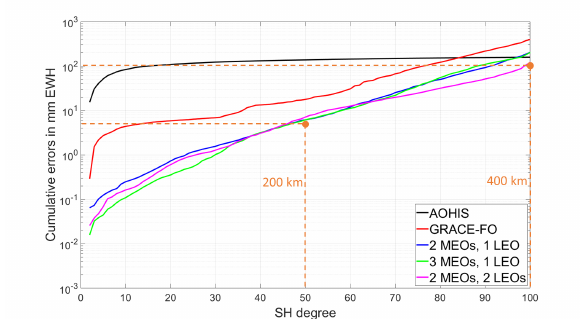
Fig. 7. Cumulative signals/errors when including instrument errors and aliasing errors from hydrology, ice and solid Earth (HIS). The threshold science requirements for 400 km (SH degree 50) and 200 km (SH degree 100) are included in orange colour.